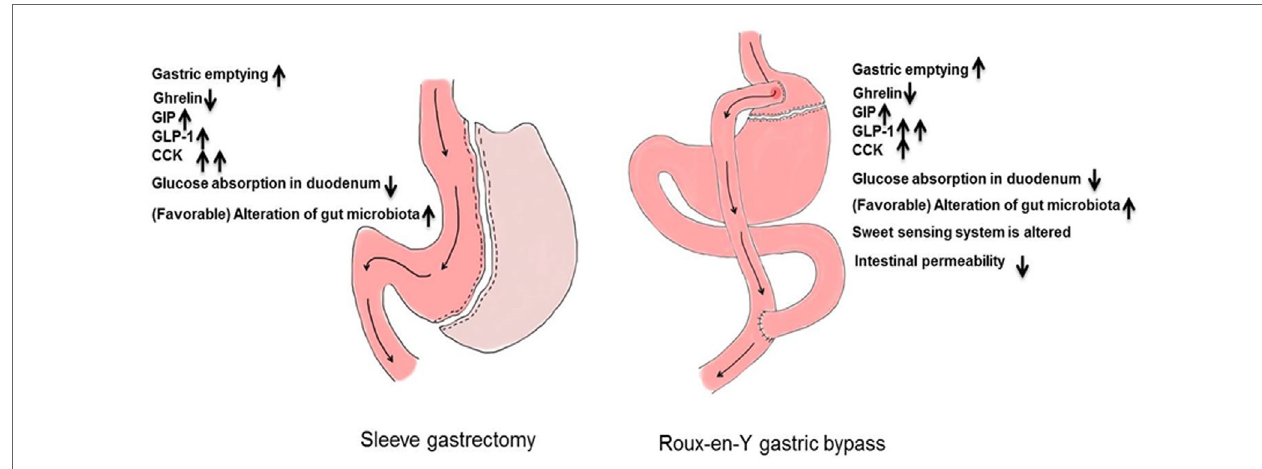
FiGURe 2 | Upper intestinal adaptions after bariatric